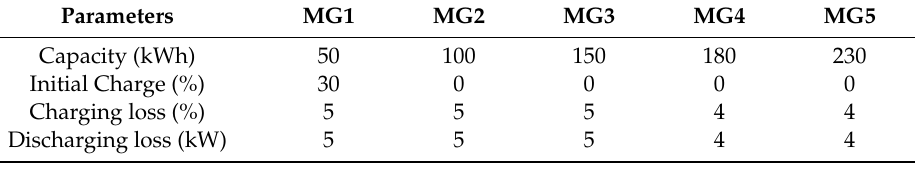
Table 2. Parameters related to battery energy storage systems (BESSs).